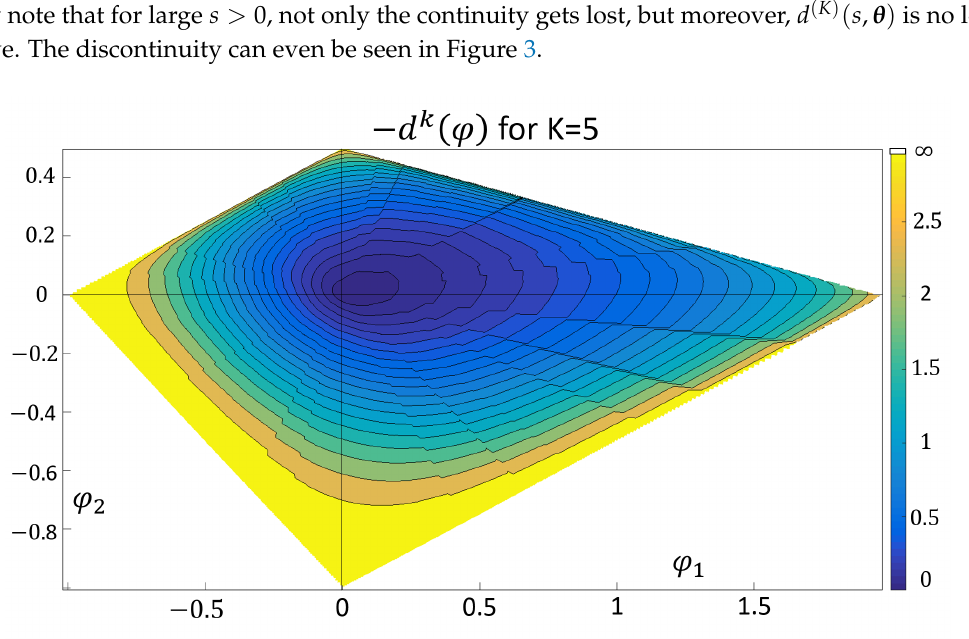
d ( K ) with K = 5 for T from Example −